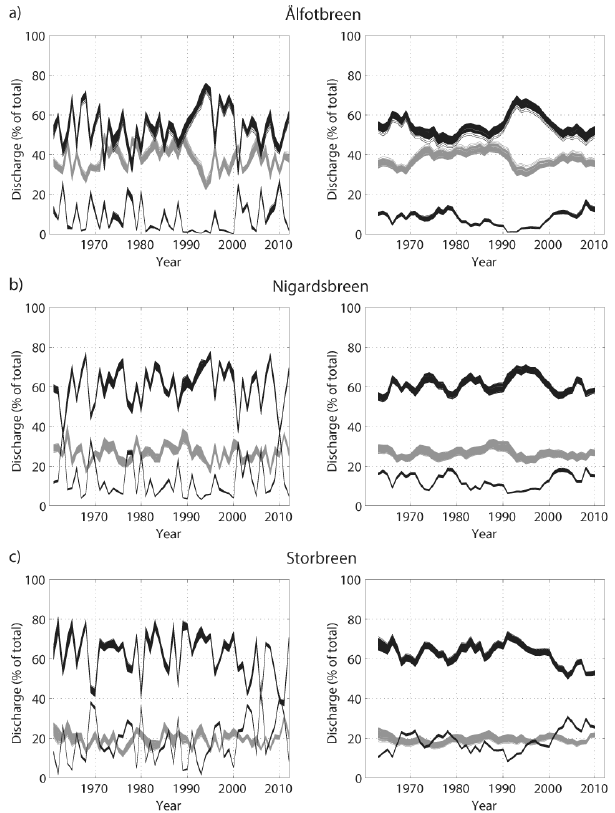
Fig. 8. Relative proportions of the contributing sources to the an- nual discharge (left column), and the respective 5yr moving average (right column). Snowmelt is represented by the upper black lines, glacier melt by the lower black lines and rain by the grey